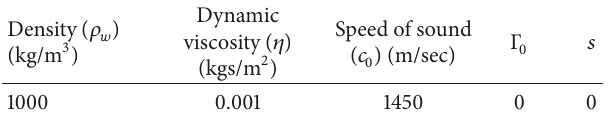
Table 1: Equation of state parameters for water.